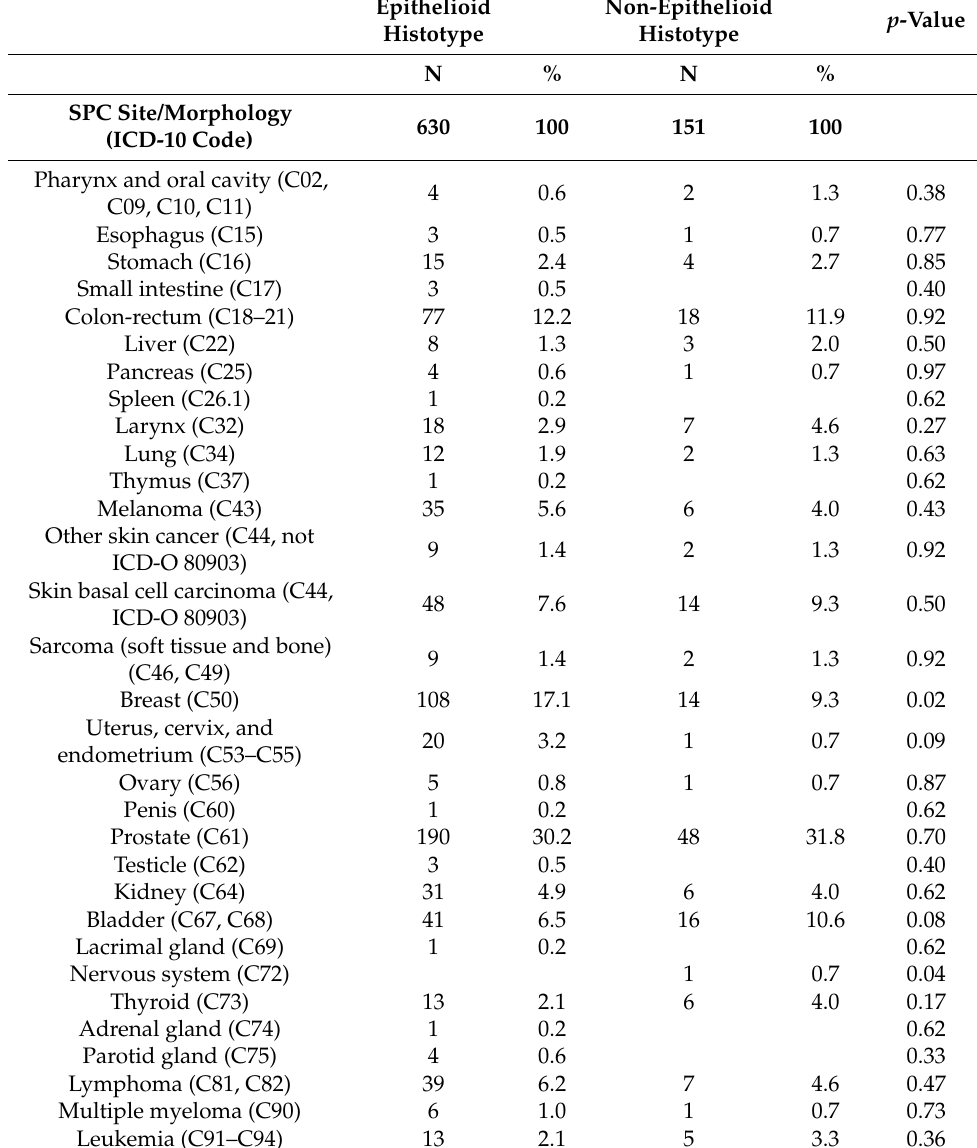
Table 3. Distribution of second primary cancer (SPC) by histotype, Lombardy,